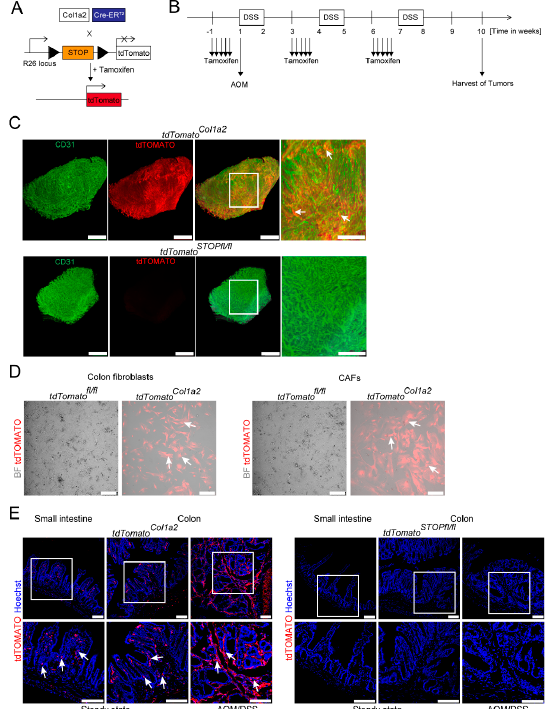
Figure 1. Intestinal fibroblasts and CAFs of the AOM/DSS model are labeled by tdTomato Col1a2 reporter mice and can be visualized by light sheet and confocal fluorescence microscopy. ( A ) Sche- matic illustration of the genetic approach based on the Cre/loxP system to trace COL1+ fibroblast by cross-breeding Col1a2- CreER T2 and tdTomato STOPfl/fl mice. Triangles represent loxP sites. ( B ) Time- line for the experimental setup of the AOM/DSS model using the tamoxifen inducible Col1a2 pro- moter. ( C ) Colon tumor tissue was harvested from the AOM/DSS model from tdTomato Col1a2 and tdTomato STOPfl/fl control mice, prepared by ECi-based tissue clearing and analyzed by light sheet flu- orescence microscopy. Individual and combined stainings of tdTOMATO (red) and CD31 (green) are shown as indicated in the 3D reconstruction. Scale bar: left 500 µm and right 250 µm. Arrows point to tdTOMATO+ cells. ( D ) Colon fibroblasts and CAFs from the AOM/DSS model were puri- fied from tdTomato Col1a2 and tdTomato STOPfl/fl control mice, as indicated and studied by fluorescence microscopy. Scale bar: 100 µm. ( E ) Tissue sections were prepared from the small intestine, the colon or AOM/DSS-induced colon tumors from tdTomato Col1a2 and tdTomato STOPfl/fl control mice and ana- lyzed by confocal fluorescence microscopy as labeled. Arrows indicate tdTOMATO+ cells. Scale bar: 100 µm. Pictures in ( C – E ) are representative of at least two independent experiments.